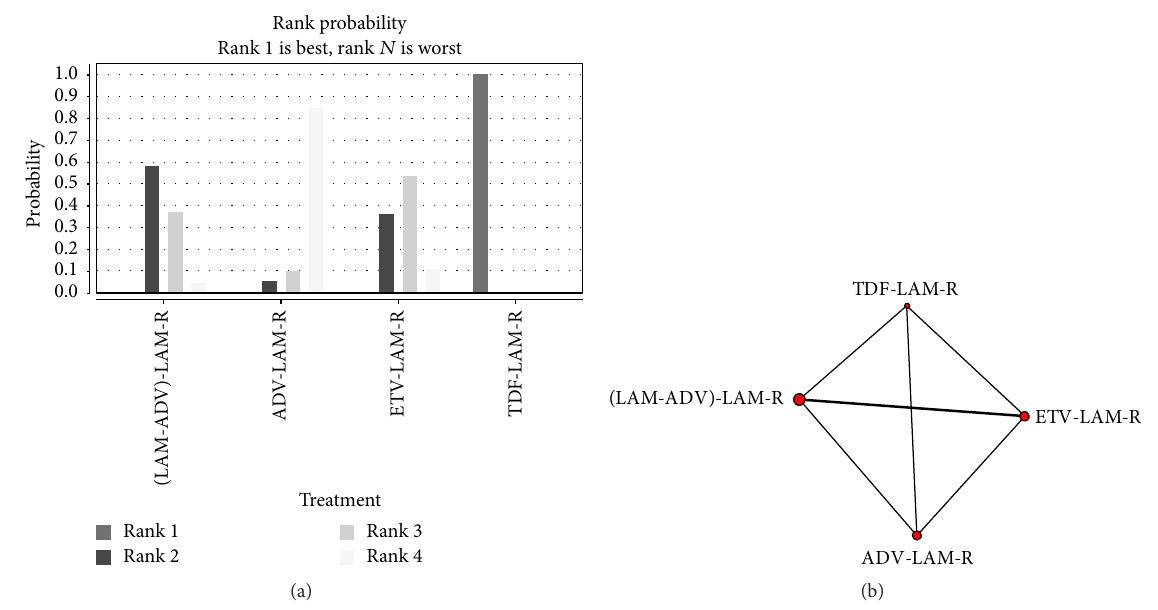
Figure 3: Rank probability and network plot of 48 weeks of undetectable HBV DNA rate. (a) rank probability. Different color indicates different rank showed in the picture; for example, the lightest color means rank 4. The highest bar in the chart of one intervention represents its rank probability. Rank 1 means the best efficiency, and rank 4 means the worst. The bar which means rank 1 in TDF treatment group is the highest bar; therefore, TDF treatment had the highest probability for achieving HBV DNA undetectable after 48-week treatment; (b) network plot. The node size indicates the sample size in the treatment group that the node stands for; the thickness of the link represents the sample size of the direct